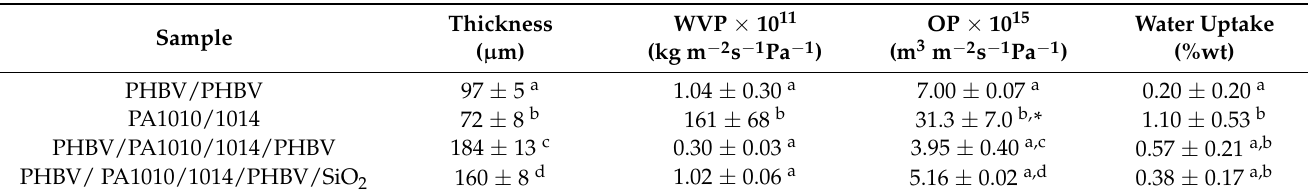
Table 7. Mean thickness, water vapor and oxygen permeances, and water uptake of the mono- and multilayer films based on PHBV, PA1010/1014, and SiO 2